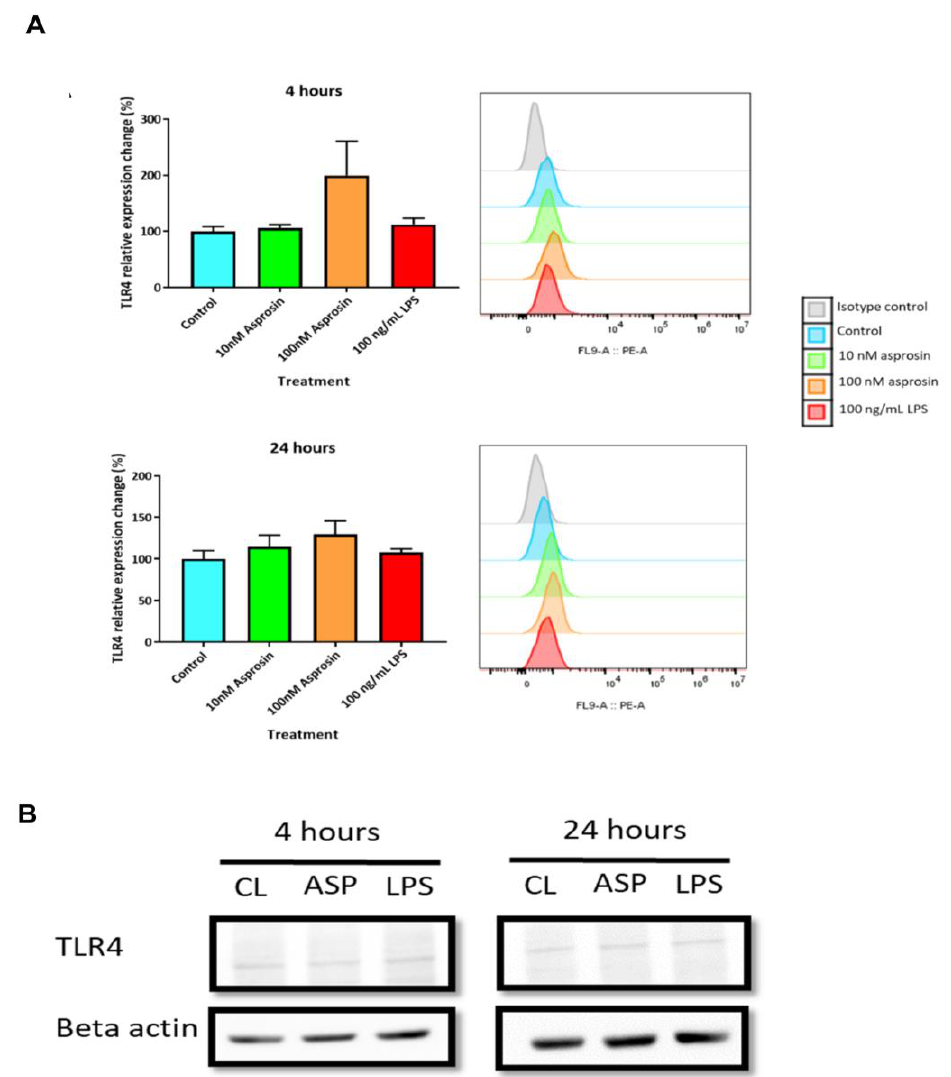
Figure 4. Asprosin did not significantly affect Toll-like receptor 4 (TLR4) surface and intracellular expression. THP-1 macrophages were treated with either 10 nM asprosin, 100 nM asprosin or 100 ng/mL lipopolysaccharide (LPS). Cell surface expression of TLR4 was measured by flow cytometry after 4 and 24 h ( A ). Flow cytometry histograms display fluorescent intensity of the TLR4-PE stain ( x -axis) and cell count ( y -axis). Data were compared using one-way ANOVA and Dunnett’s multiple comparisons test (compared to control) ( n = 3). THP-1-cells (1 × 10 6 cells/well) were seeded and differentiated into macrophages in 6-well plates. Cells were then treated with either 100 nM asprosin or 100 ng/mL LPS for 4 and 24 h; collected and lysed for intracellular protein expression was measured by Western blotting ( B ). The presented Western data are representative of three independent experiments ( n = 3). CL: control; ASP: asprosin; LPS: lipopolysaccharide.